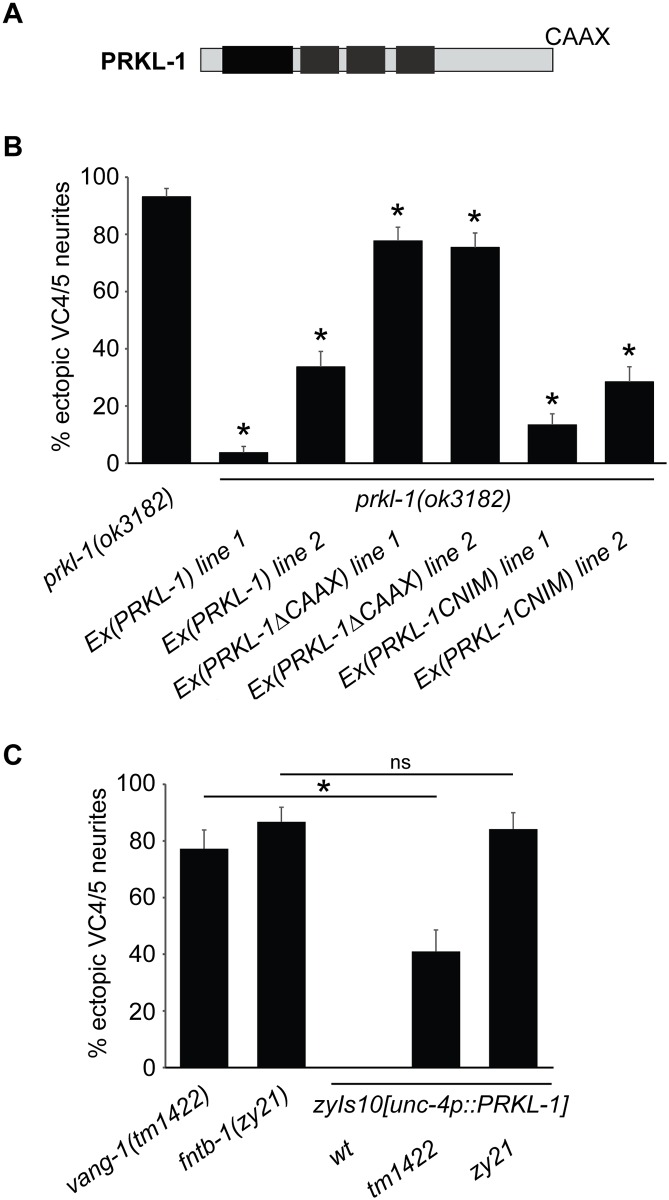
The PRKL-1 CAAX motif is necessary for normal VC4 and VC5 morphology.(A) Schematic of PRKL-1 showing conserved domains (black boxes) and C-terminal CAAX motif. (B) Expression of CAAX deleted PRKL-1 does not rescue VC4 and VC5 morphology defects in prkl-1 mutants as well as full length PRKL-1. Replacement of the PRKL-1 CAAX motif with the CNIM motif from MIG-2 resembles wildtype PRKL-1 in rescuing VC4 and VC5 morphology defects. (C) PRKL-1 overexpression can rescue VC morphology defects in vang-1 mutants but not fntb-1 mutants. All transgenic lines in B and C contain unc-4 promoter-driven PRKL-1 constructsand all lines contain the cyIs4[Pcat-1::GFP] reporter background. Error bars represent the 95% confidence interval of the proportion, n>150. *p<0.001, t test.